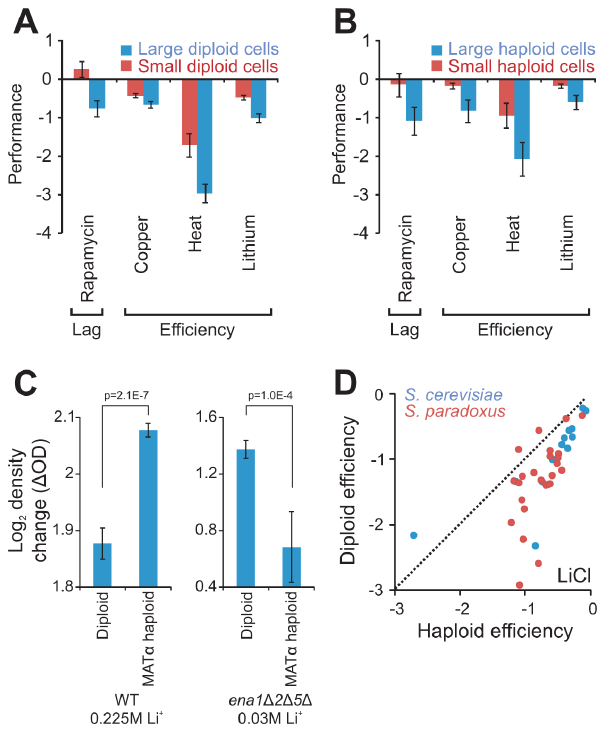
Figure 4. Cell size partially explains ploidy–environment interactions. A–B) Fitness components measures with a significant (FDR, a =0.05) difference, both between large (n=10) and small (n=10) S288c haploids and between large (n=29) and small (n=20) S288c diploids. Large and small cells were constructed through individual deletion of different cell size defining genes. Note that data is shown on a log(2) scale. rror bars represent SEM. A) Performance of large and small diploid cells. B) Performance of large and small haploid cells. C) The tandem genes encoding the Li + exporters ENA1 , 2 and 5 , were deleted in the haploid S288c derivative BY4741 and the haploid deletion strain was autodiploidized through mating type switching. The total change in density (the efficiency) of mitotically reproducing populations exposed to 30 mM LiCl was obtained for ena1 D 2 D 5 D haploids (n=8) and diploids (n=56) and compared to that of WT